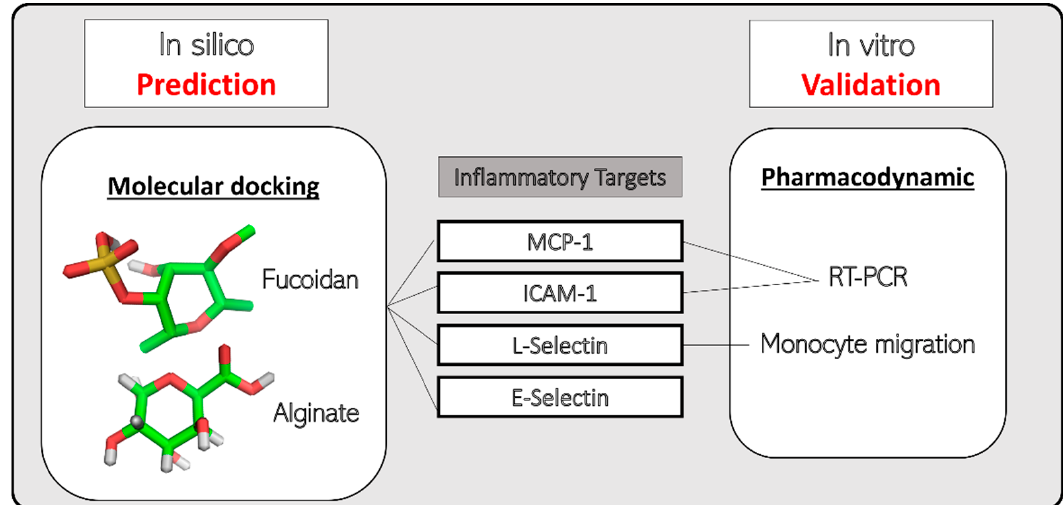
Figure 1. Study approach for prediction and validation of marine bioactive compounds (fucoidan and alginate) with inflammatory protein targets.